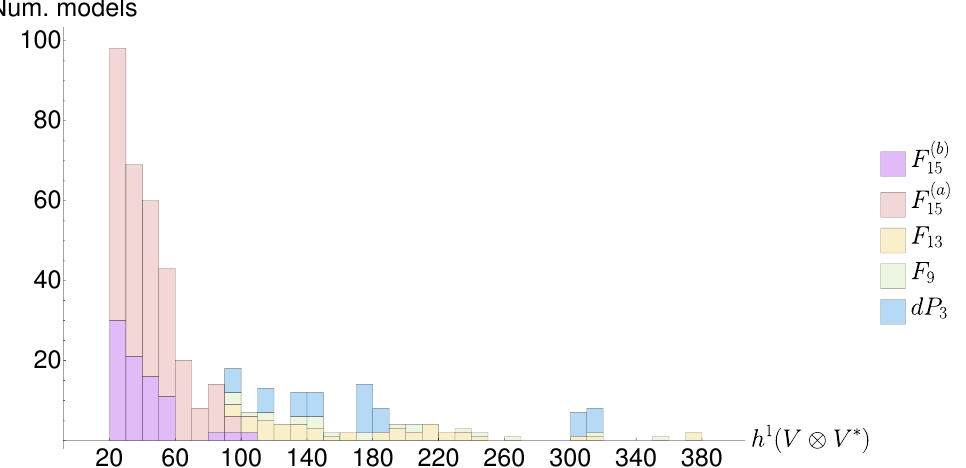
Figure 4 . Frequency plot of h 1 ( V (cid:10) V (cid:3) ) which gives the number of singlet (cid:12)elds, combined for all base